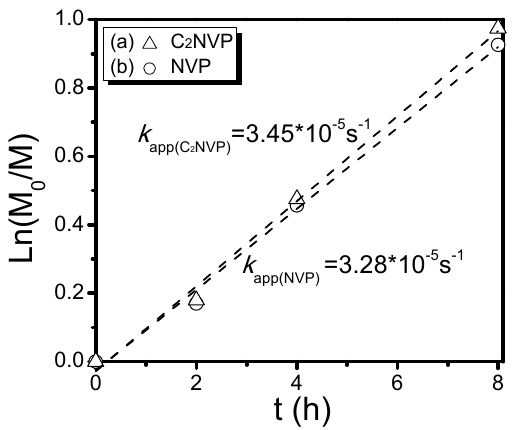
Figure 2. Kinetic of RAFT copolymerization of C 2 NVP and NVP (Monomers/MHEX = 200/1 in EtOH at 70 °C; [C 2 NVP] 0 = 1.50 M and [NVP] 0 = 0.75 M).